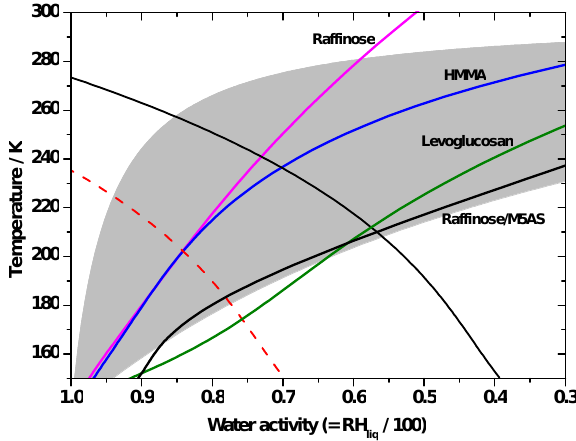
Fig. 1. An aerosol state diagram comparing the estimated range of the relative humidity induced glass transition threshold (RH g ) for atmospheric SOA (grey area) (Koop et al., 2011) and the RH g thresholds (Zobrist et al., 2008) for the aerosols investigated in this study. The solid black line is the ice-liquid equilibrium and the dashed red line is the homogeneous freezing threshold for liquid solution droplets (Koop et al., 2000). All the aerosols tested have T 0 g values (the point at which RH g and the ice liquid equilibrium intersect) in the range predicted for SOA, indicating that they are reasonable surrogates for glassy atmospheric SOA. For a more de- tailed explanation of aerosol state diagrams see Sect.